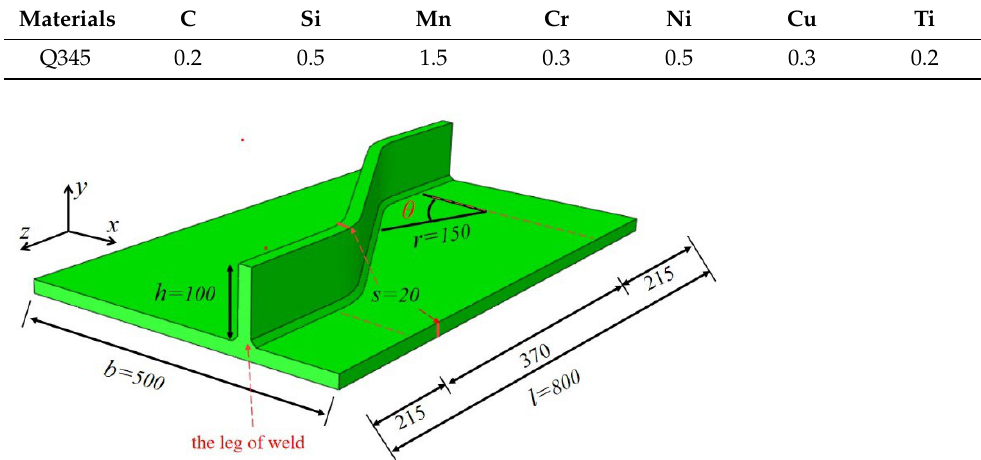
Table 1. Chemical composition (wt. %) of Q345 medium carbon steel.